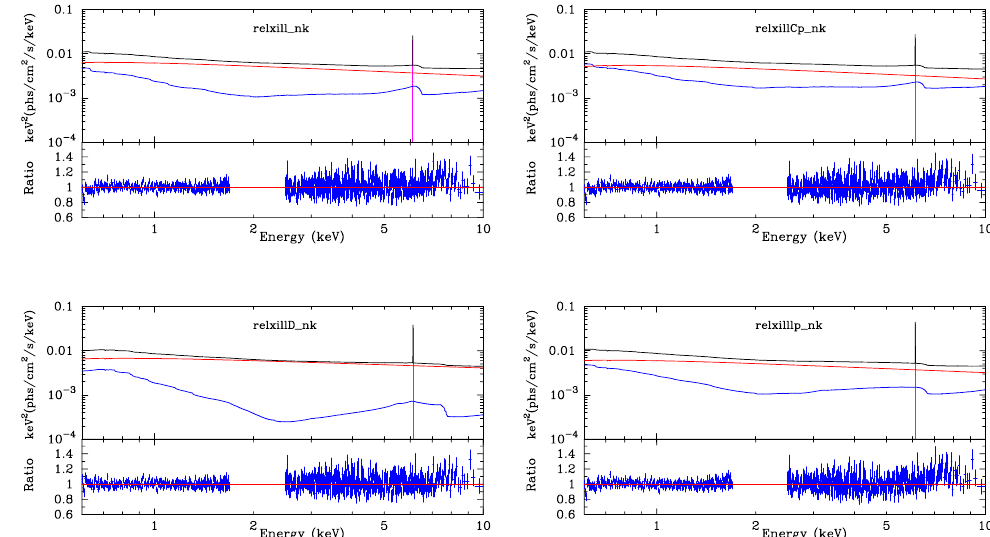
Figure A10. Spectra of the best fit models with the corresponding components ( upper panels ) and data to best-fit model ratios ( lower panels ) for PKS 0558–504 when the reflection component is modeled by RELXILL _ NK ( top left panel ), RELXILL C P _ NK ( top right panel ), RELXILL D_ NK ( bottom left panel ), and RELXILLLP _ NK ( bottom right panel ). The total spectra are in black, power law components from the coronas are in red, the relativistic reflection components from the disk are in blue, and the gaussian line is in magenta.